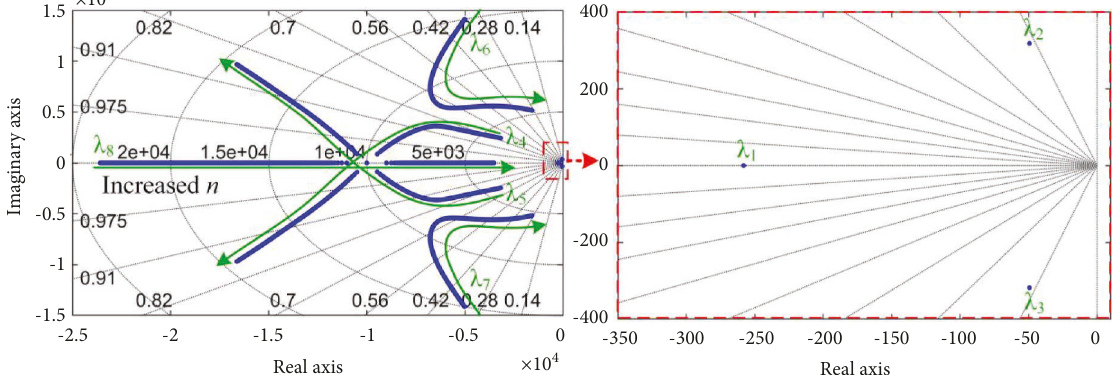
Figure 15: Generalized root locus diagram of G